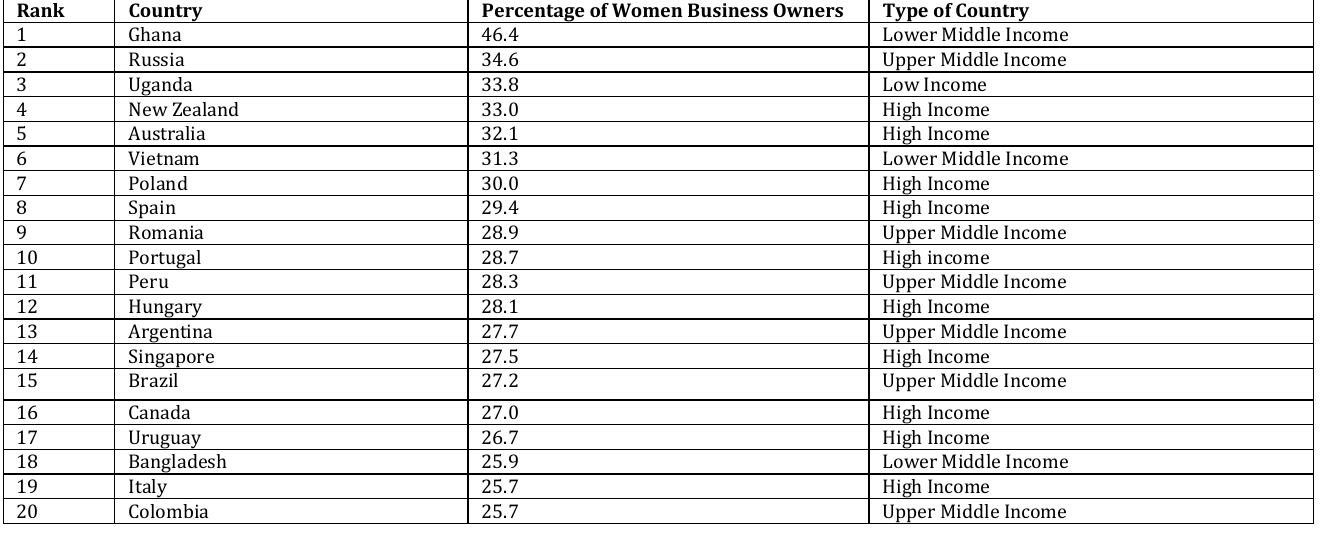
Table 1: Country-wise Percentage of Women Business Owners as a Percentage of Total Business Owners (2018)